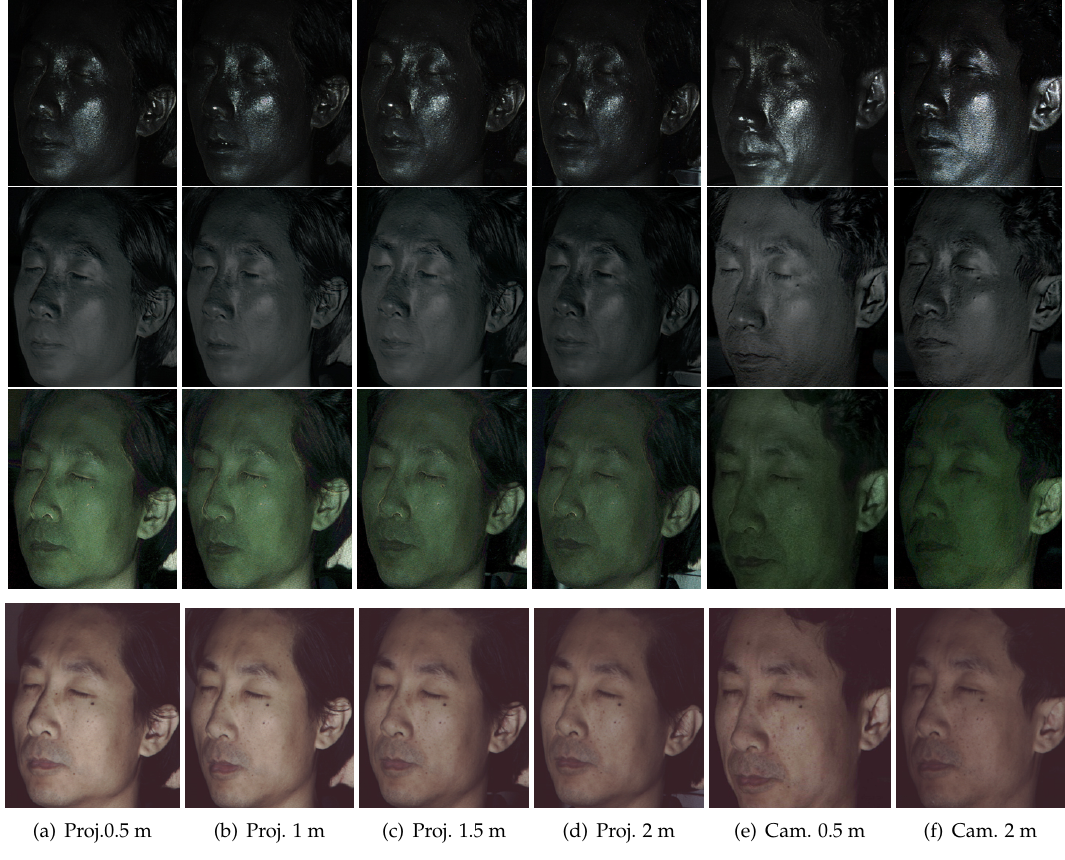
Figure 8. Layered reflectance separation (specular-only, single, shallow and deep scattering from top to bottom) depending on various imaging conditions. A Lytro Illum camera for TPLF imaging was placed at a 1.5-m distance from the subject, and an LCD projector attached with a linear polarization filter was placed at 0.5, 1, 1.5 and 2 m from first to fourth column. The LCD projector was placed at a 1-m distance from the subject, and the Lytro Illum camera was placed at 0.5 m (fifth column) and 2 m (sixth column).